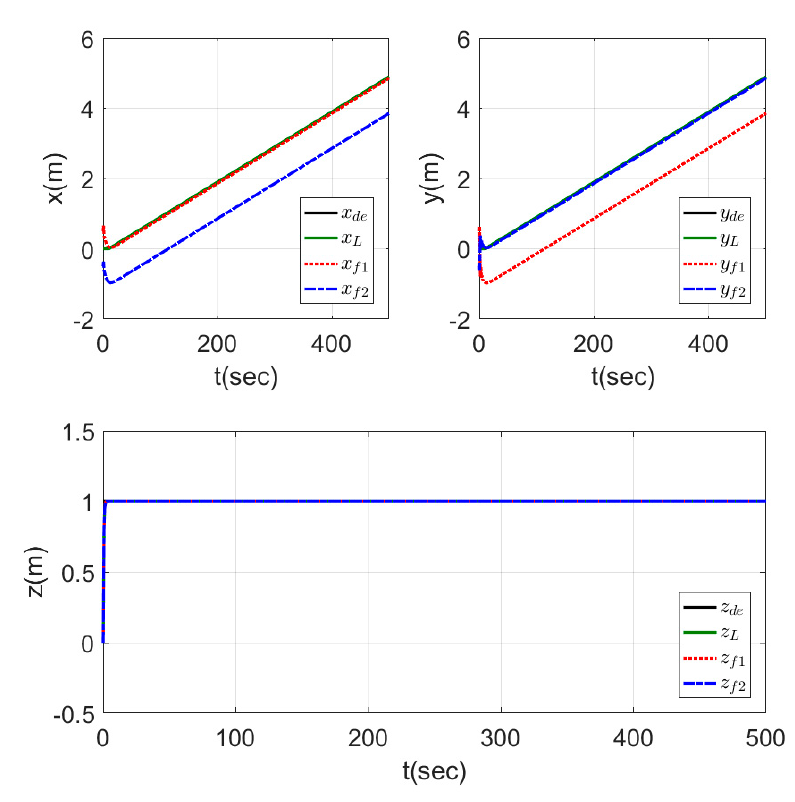
Figure 15. Time response of fixed formation tracking ramp trajectory.